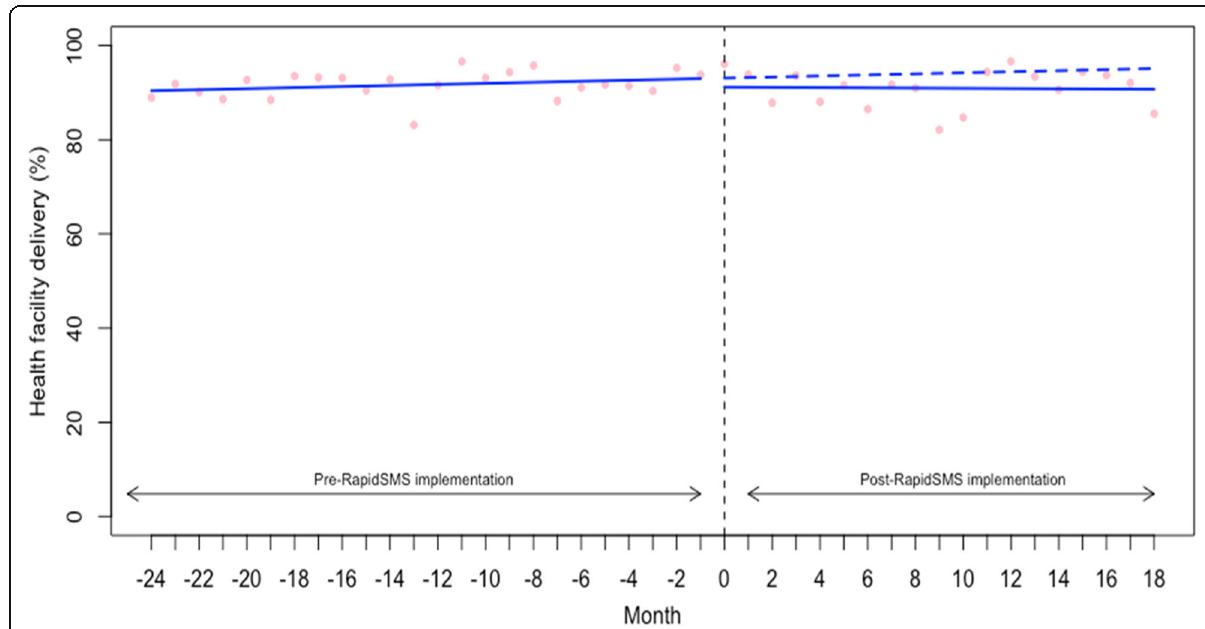
Fig. 4 Interrupted time series analysis of health facility